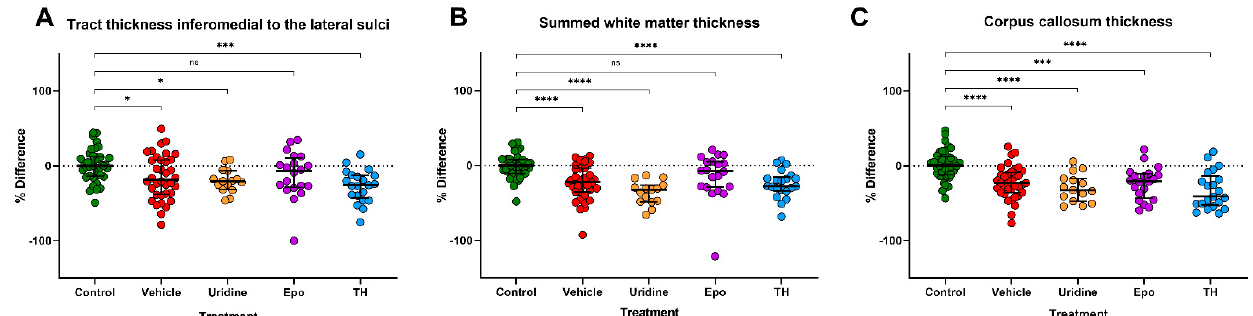
Figure 5. Quantitative IHC. ( A ) After measuring the subcortical white matter (SWM) tract thickness of the area inferomedial to the lateral sulcus in the GFAP–stained slices, the length of the WM tracts (median % difference; IQR) was significantly decreased in Veh (15.4%; 5.1–31.8%), Ur (20.2%; 6.3–31.3%), and TH (25.6%; 12.5–42.8%) brains when compared to controls. ( B ) In the three regions of interest (ROIs) in the white matter measured, the summed measurements of tract thickness were significantly thinner in Veh (15.6%; 1.6–30.0%), Ur (32.0%; 26.1–48.3%), and TH (27.6%; 15.2–33.6%) brains when compared to control brains. Epo brains had white matter thickness more consistent with controls in all ROIs. ( C ) Compared to controls, the corpus callosums (CC) of the Veh (21.4%; 3.9–40.6%), Ur (32.6%; 17.0–47.3%), Epo (25.1%; 12.7–44.9%), and TH (41.0%; 13.6–52.3%) brains were significantly thinner when compared to the CC of control brains. * Denotes p –value < 0.05, *** denotes p –value < 0.001, **** denotes p –value < 0.0001, and ns denotes no significant difference.